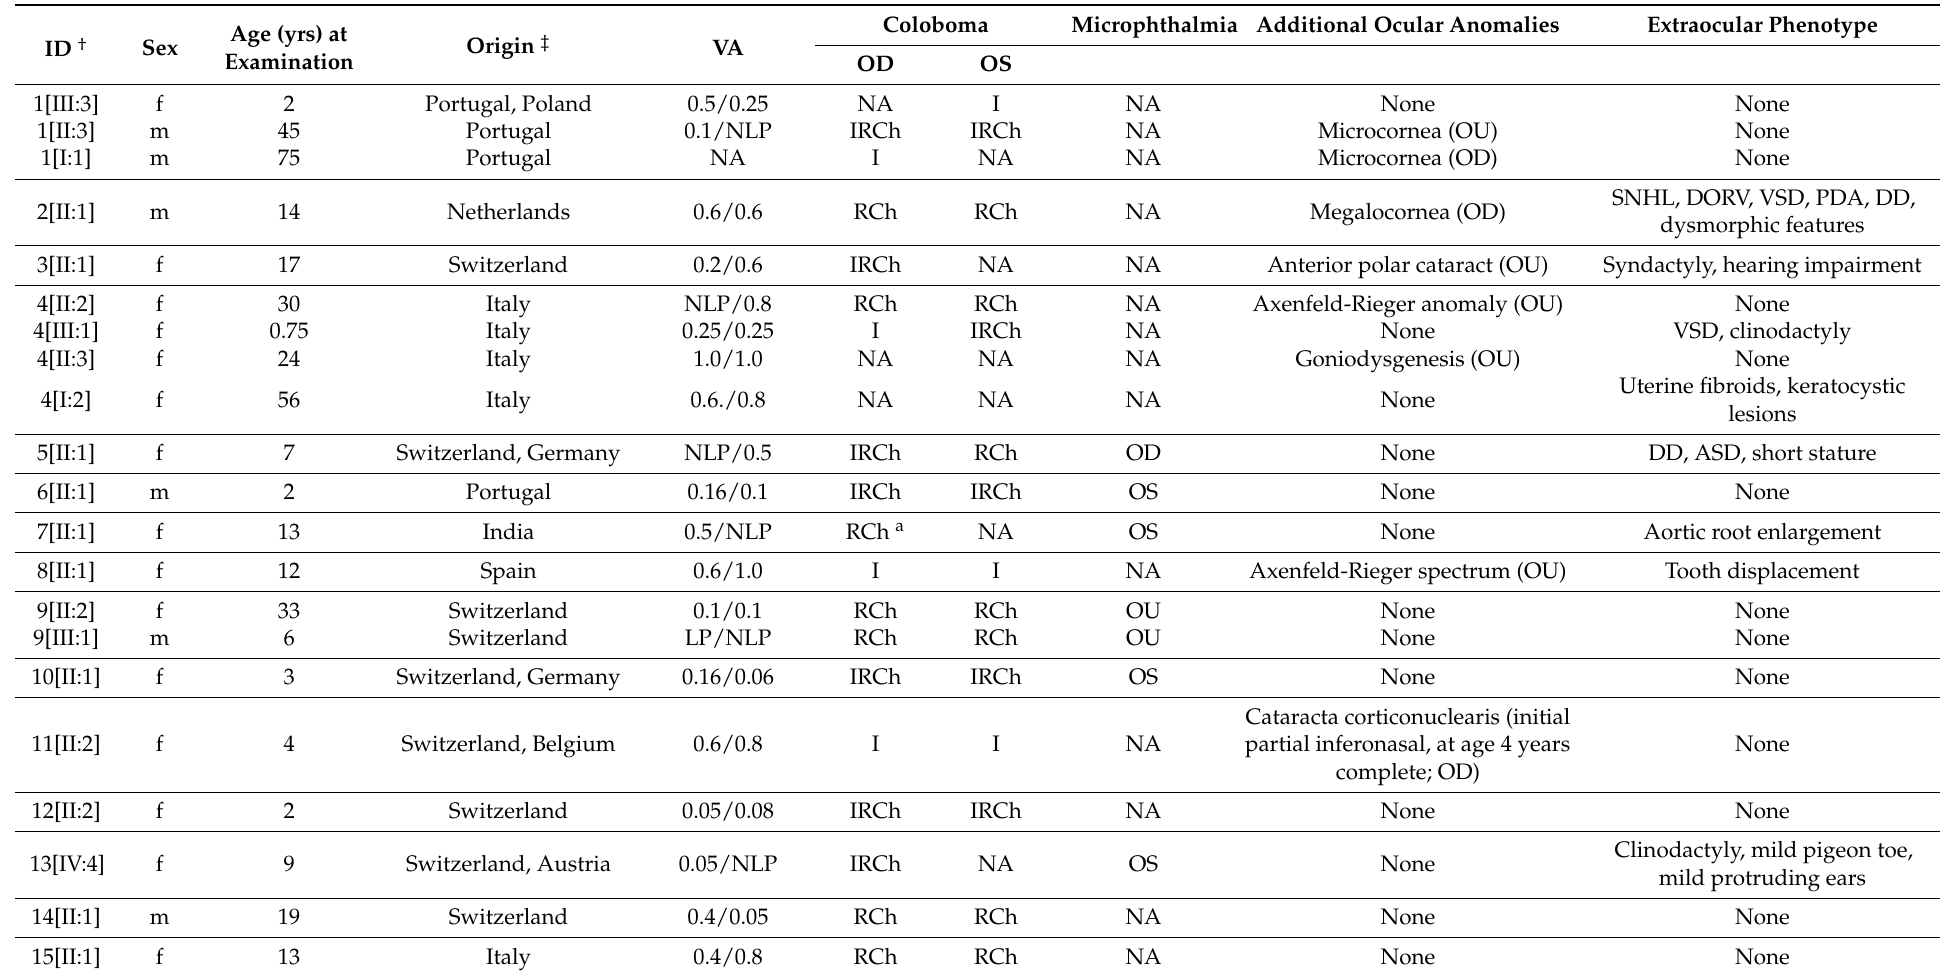
Table 1. Clinical details of index patients, affected family members, and asymptomatic